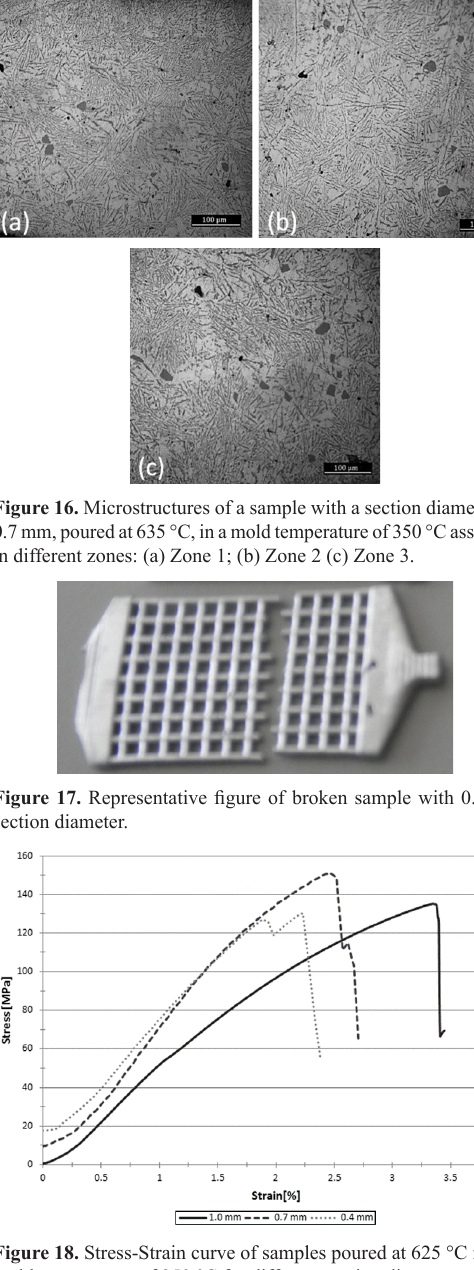
Figure 18. Stress-Strain curve of samples poured at 625 °C into a mold temperature of 350 °C for different section